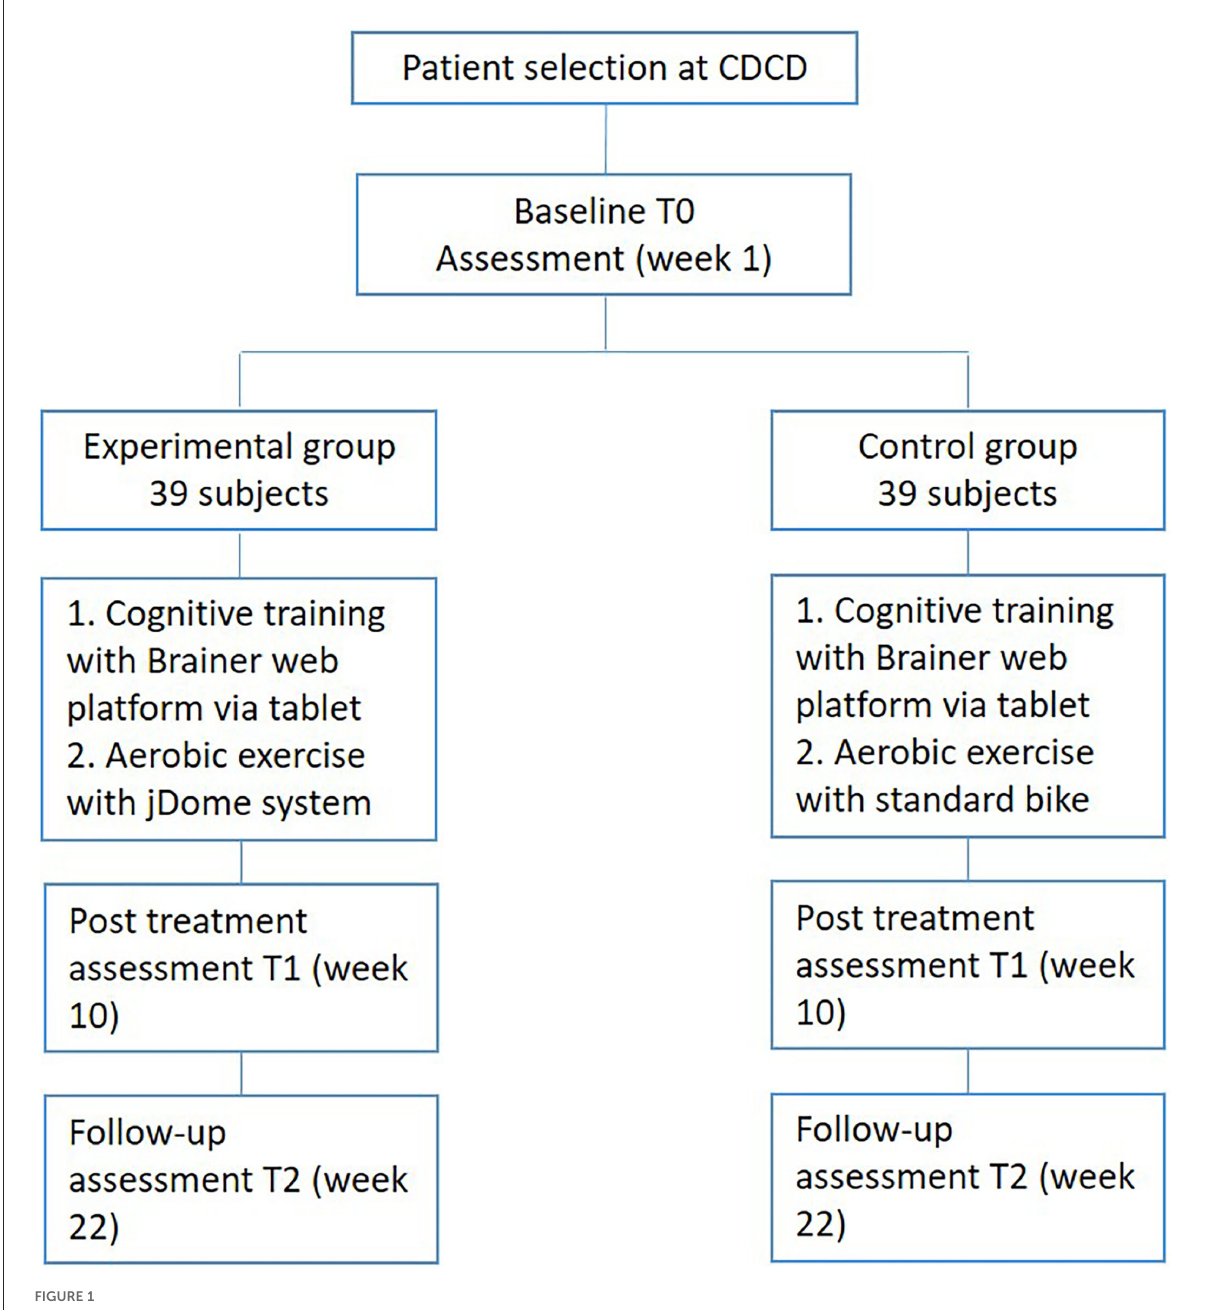
FIGURE1 Flowchart of the patient